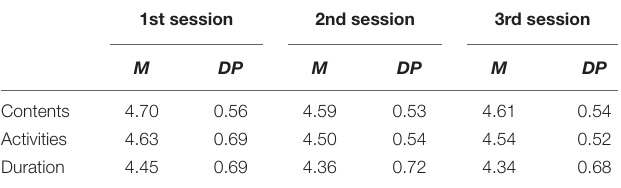
TABLE 4 | Students’ evaluation of the three sessions.